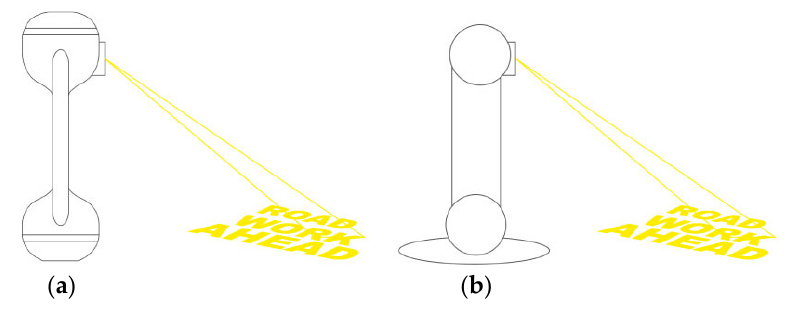
Figure 8. ( a ) Projection; ( b ) simple R-R manipulator and the kinematics.